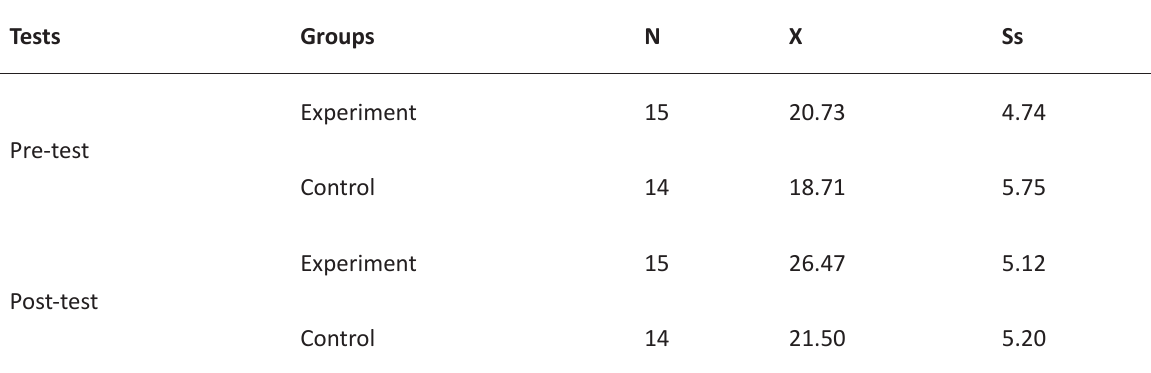
Table 1. Comparison of Hand-Eye Coordination of Pre and Post Test Results of Boxers Tests